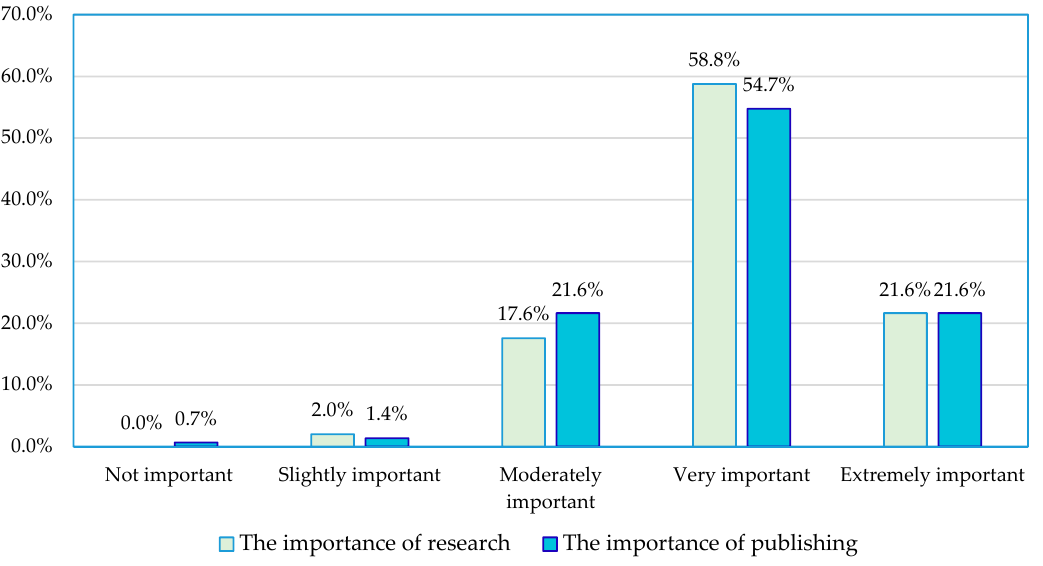
Figure 2. University lecturers’ perception of the importance of research and publishing.